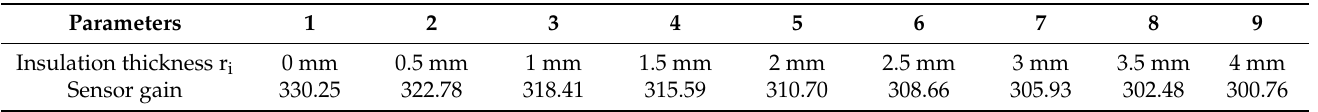
Table 2. Change the measurement thickness.